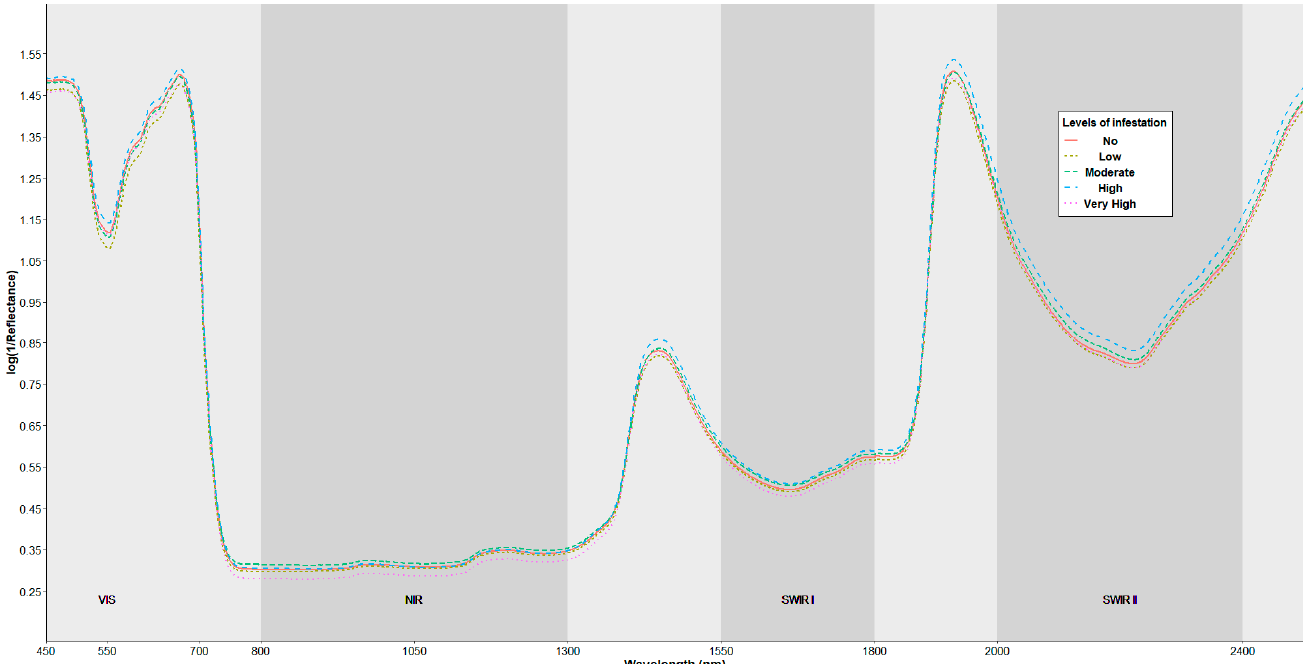
Figure 7. Transformed signatures associated with different infestation levels.